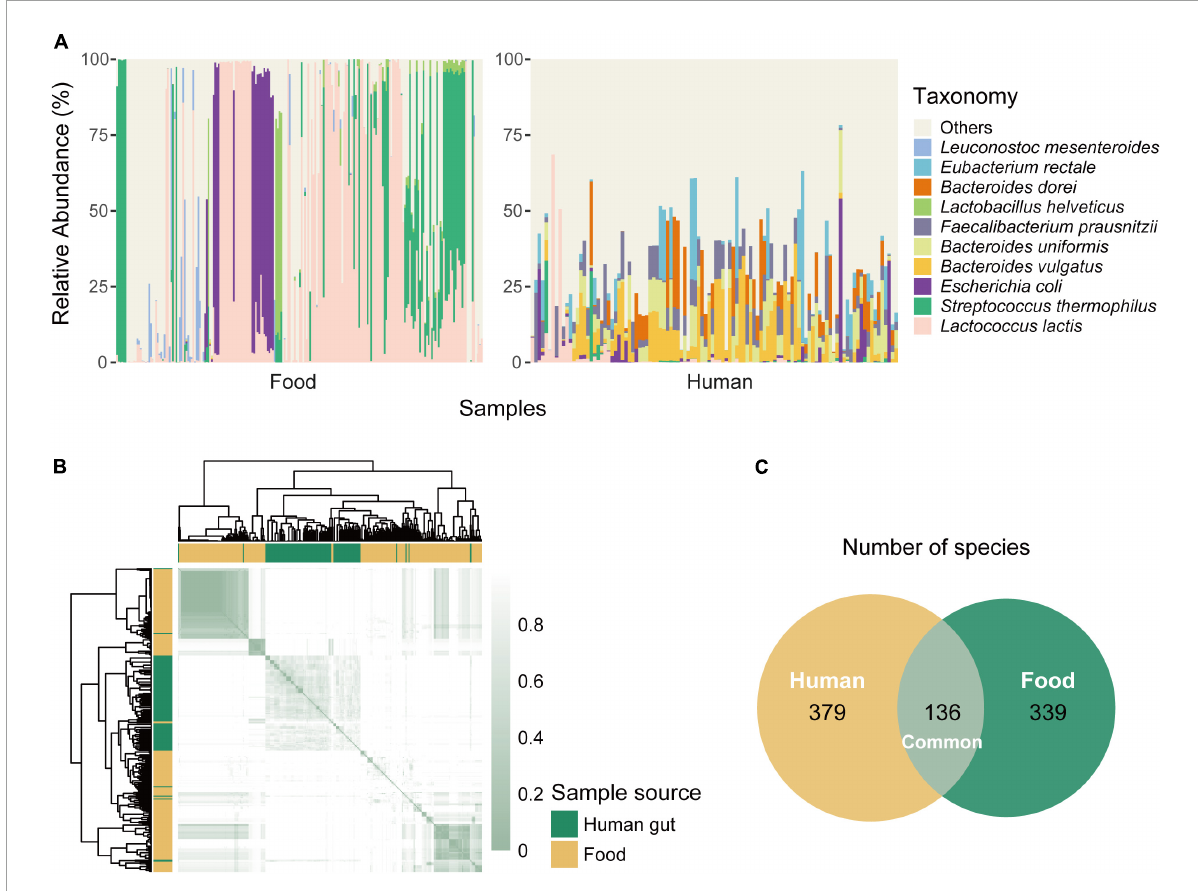
FIGURE2 Differences in species composition between food and human gut samples. (A) Species composition of food and human gut metagenomes. We only select samples that were positive for Lactococcus lactis and then display the ten most abundant species among all samples. The left part shows the relative abundance of each food sample, while the right part is for gut samples. (B) Difference of species abundance between samples. Samples positive for L. lactis are used and Bray-curtis distances are calculated. The smaller the value of the distance is (the deeper the color is), the more similar the two samples are. Annotation strip distinguishes the sample sources, green marks human samples, and yellow marks food samples. (C) The number of species present in food and human niches. There are 136 common species, 379 species unique to human samples, and 339 species unique to food